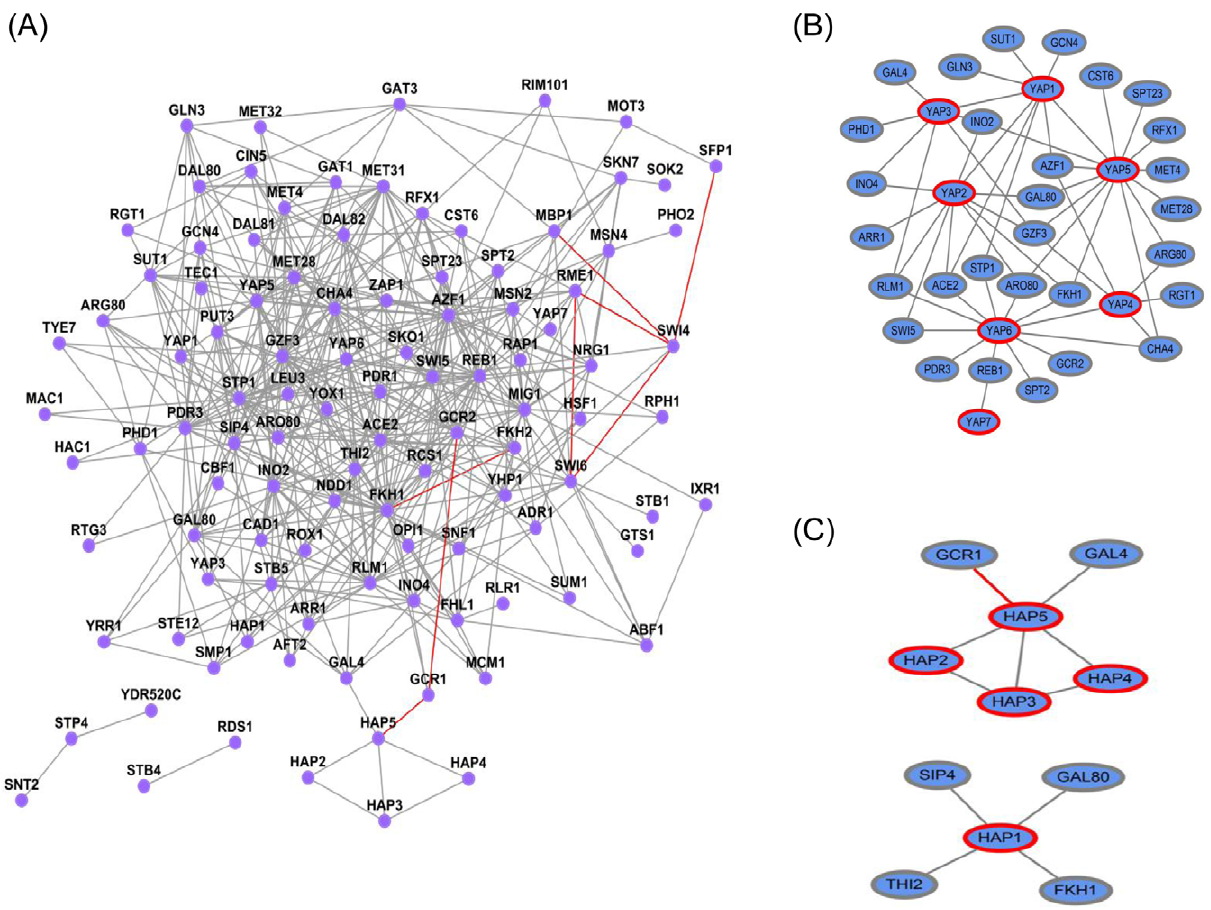
Figure 5. A network of the predicted synthetic lethal interactions between yeast transcription factors (TFs). (A) A global TF SL interaction network including 467 predicted and 8 experimentally verified interactions from SGD (highlighted in red). (B) YAP-TF related synthetic